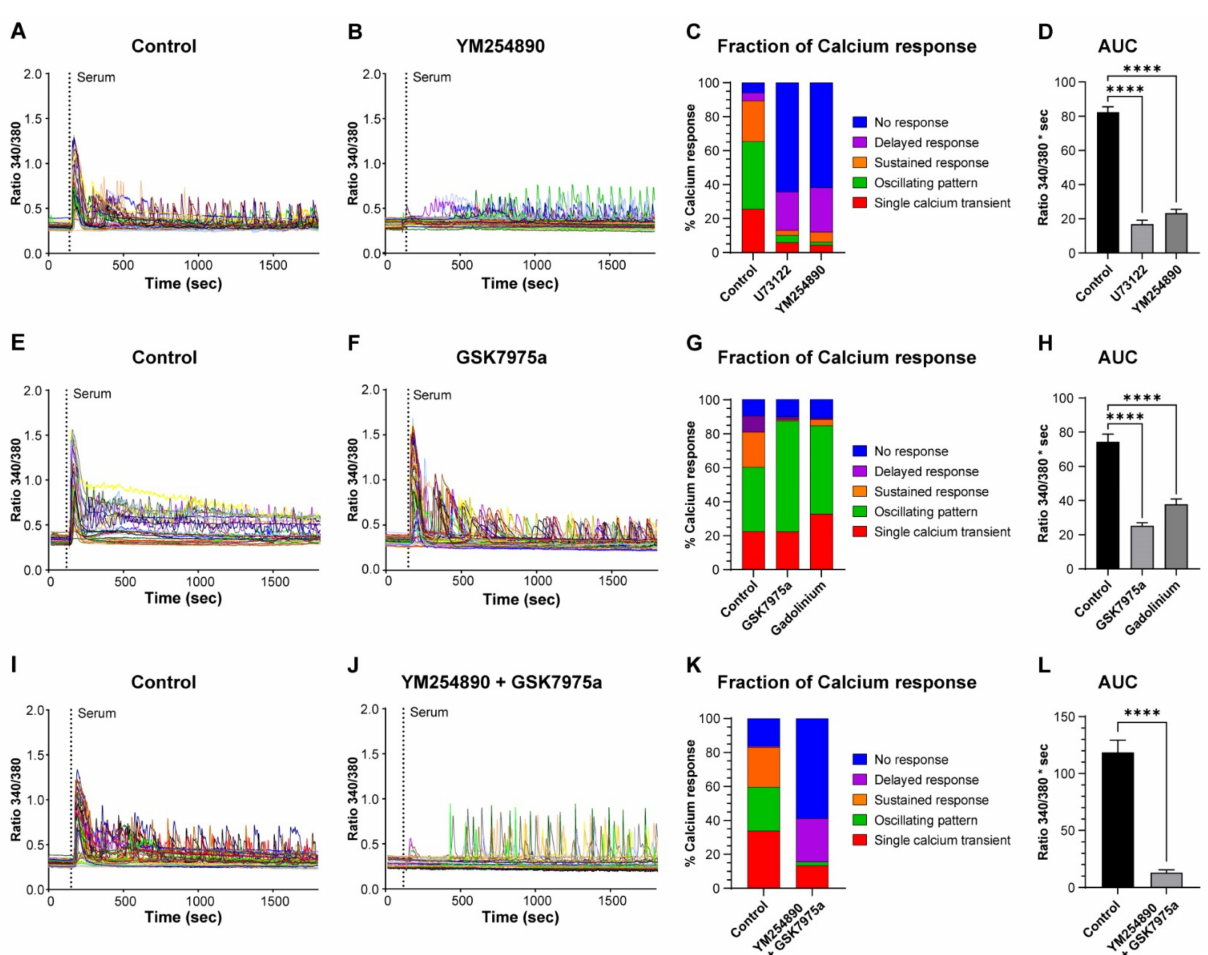
Figure 4. IP 3 -induced Ca 2+ release and Ca 2+ entry account for most of the serum-induced Ca 2+ response. Myoblasts were differentiated for 48 h to obtain myotubes and RC. The cells were loaded with Fura-2 and stimulated by 15% serum in the control condition ( A , E , I ) and after preincubation with 10 µ M YM254890 ( B ), 10 µ M GSK7975a ( F ), or both inhibitors ( J ). Each panel ( A , B , E , F , I , J ) is the response of a representative coverslip, with the control of each inhibitory condition displayed. The proportion of each type of Ca 2+ response is shown after inhibition of IP 3 production with YM254890 and U73122 ( C ), inhibition of Ca 2+ entry with GSK7975a or Gd 3+ ( G ), or both inhibitions with YM254890 and GSK7975a ( K ). Quantification of the area under the curve (AUC) of the Ca 2+ responses in the control condition and treatments of the blockers ( D , H , L ). For panel ( H ), the AUC was calculated by omitting the first 3 min of the response that corresponded to the Ca 2+ release phase, while for panels ( D , L ), the full responses were considered to calculate the AUC. Statistics were calculated with a Kruskal–Wallis test and Dunn’s multiple comparisons test ( D , H ) or with a Mann–Whitney test ( L ) **** p < 0.0001). Bars are mean ± SEM. For each condition, n varied between 307 and 731 cells from 7–16 independent